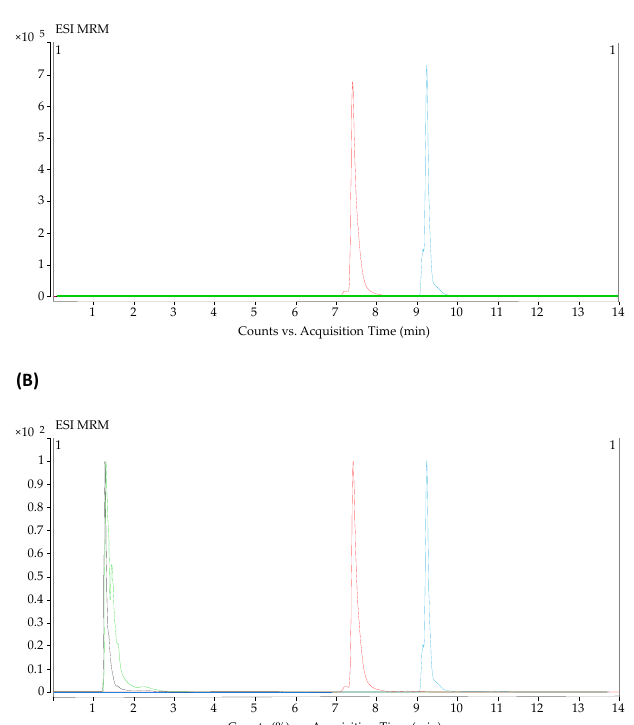
Figure 1. The effect of mobile phases modifier on fatty acid. ( A ) Chromatographic profile of LPC 16:0 (red) and LPE 18:0 (blue) using ammonium formate as modifier. Oleic (black) and lauric acid (green) showing zero abundance. ( B ) Chromatographic profile of LPC 16:0 (red) and LPE 18:0 (blue) using ammonium acetate as